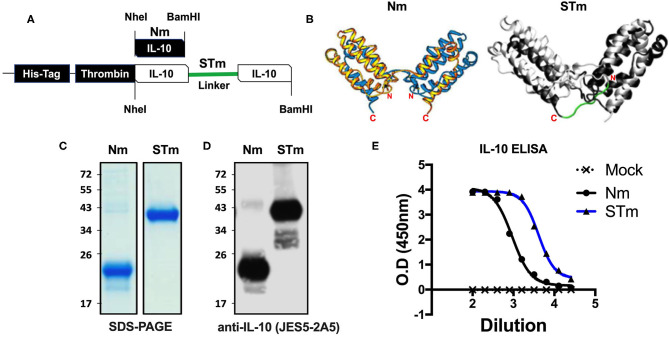
Expression and ELISA measurement of natural and stable mouse IL-10. (A) The cDNA construct of both natural mouse IL-10 (Nm) and stable mouse IL-10 (STm). The cartoon illustration of the expected protein folding of both Nm and STm versions. (B) The ribbon plot of the natural IL-10 homo-dimer with N and C terminus obtained from the previous study (13) and the molecular dynamics simulation of stable IL-10. The basis for this simulation is the crystal structure of the hIL-10 dimer (33) (PDB-ID: 2ILK). After about 2 ns of simulated time, the state of the system shown here was found. The peptide linker (-G3SG3-) is colored red. The molecular simulation of stable IL-10 was carried out by Jan-Philip Gehrcke (Biotechnology Center Dresden). (C) Both Nm and STm were stained with Coomassie Blue under reducing condition in SDS-page and (D) detected by IL-10 antibody in Western Blot. (E) Nm (black line) and STm proteins (blue line) were detected ELISA (1/2 dilutions). All data are representative of triplicate wells, and the bars represent standard error of the mean.